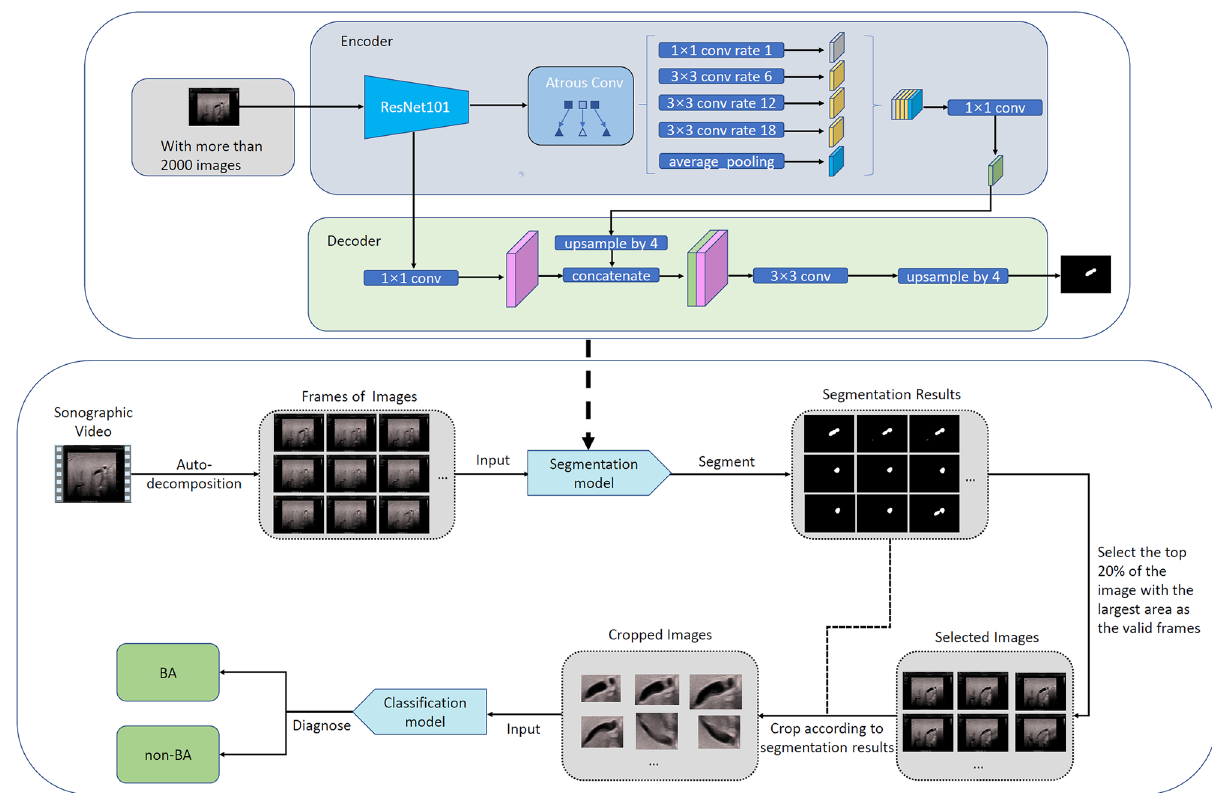
Fig. 5 The diagnostic process for each sonographic gallbladder video by the ensembled deep learning model. BA biliary